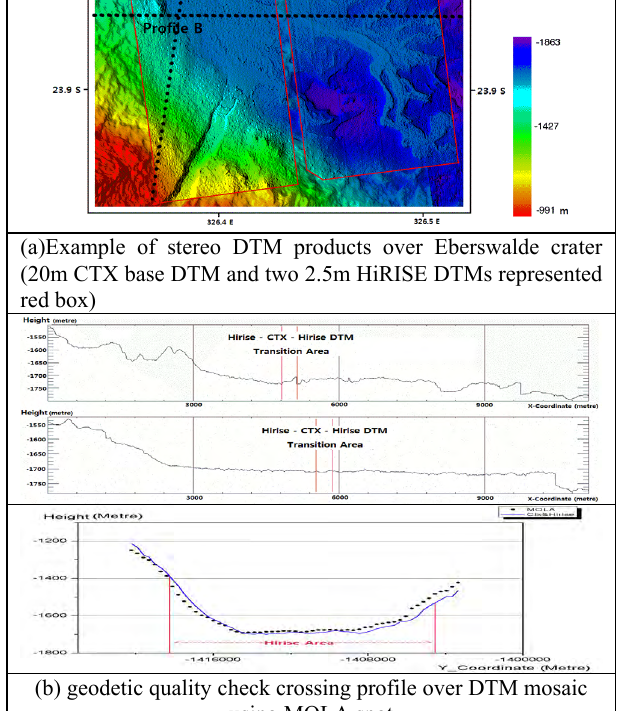
Figure 1. Example of stereo DTM products over Eberswalde crater and geodetic quality